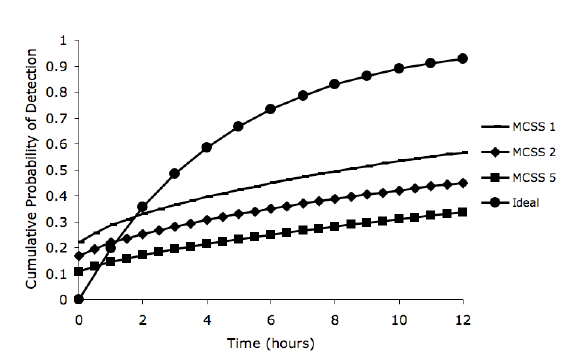
Fig.10. Average CPD of Final USDEA Mesh Fields Communications Range = 11 kyd